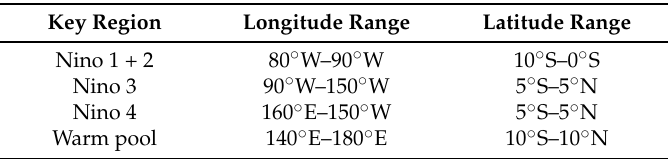
Table 1. The key regions of tropical